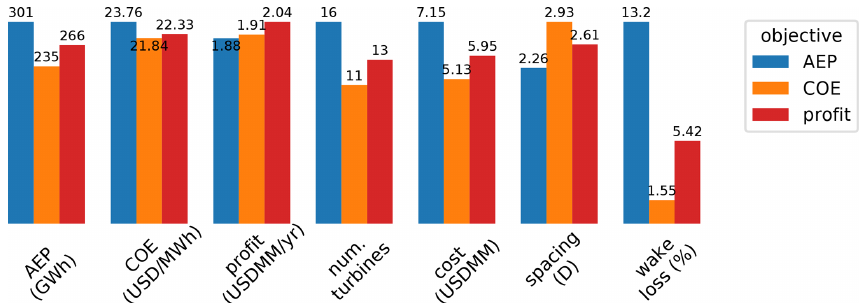
Figure 8. A comparison of the performance metrics of the three different wind power plants optimized for different objective functions. These results are shown for the small wind plant with a unidirectional wind